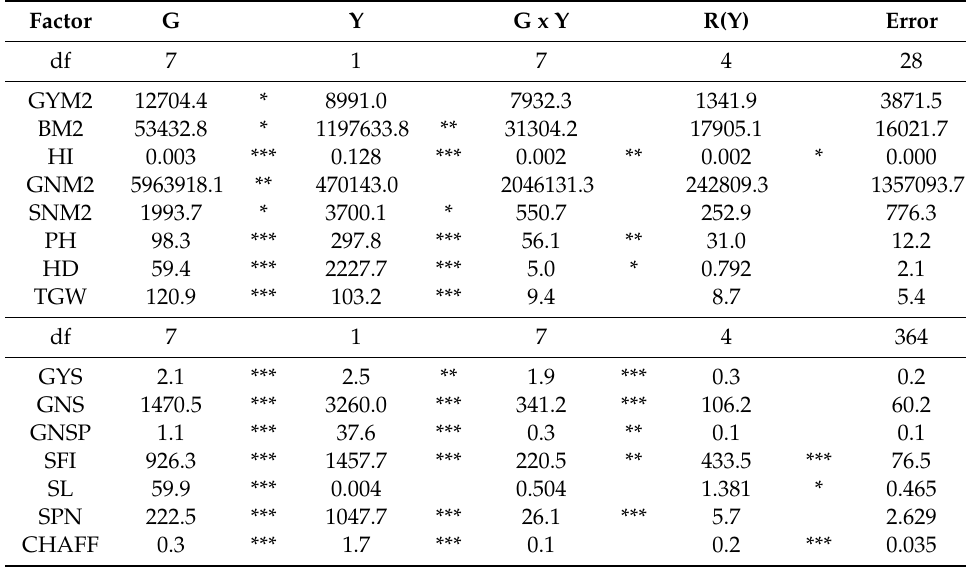
Table 3. Mean squares from the GLM for yield and yield-related traits of the 8 genotypes across the 2015 and 2016